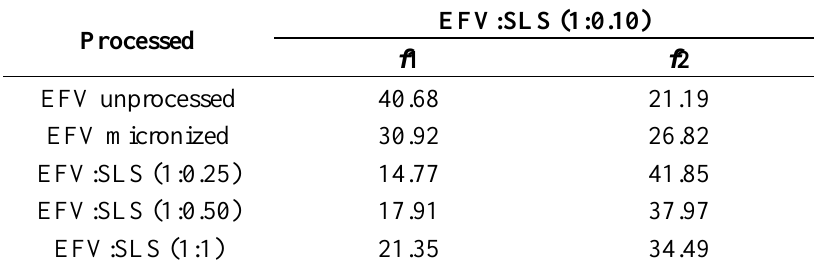
Table 7. Values of f 1 and f 2 found for processed EFV:SLS (1:0.10) compared to the unprocessed and micronized drug and other EFV:SLS